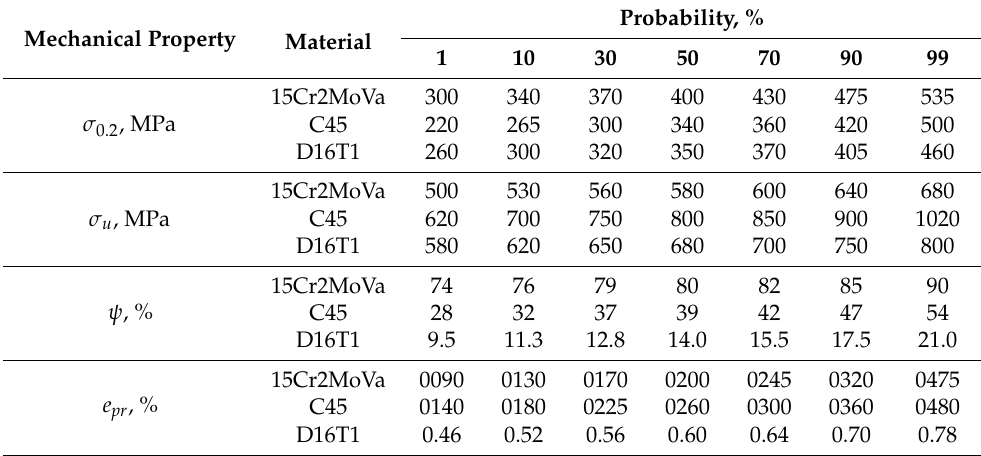
Table 8. Probability values of mechanical